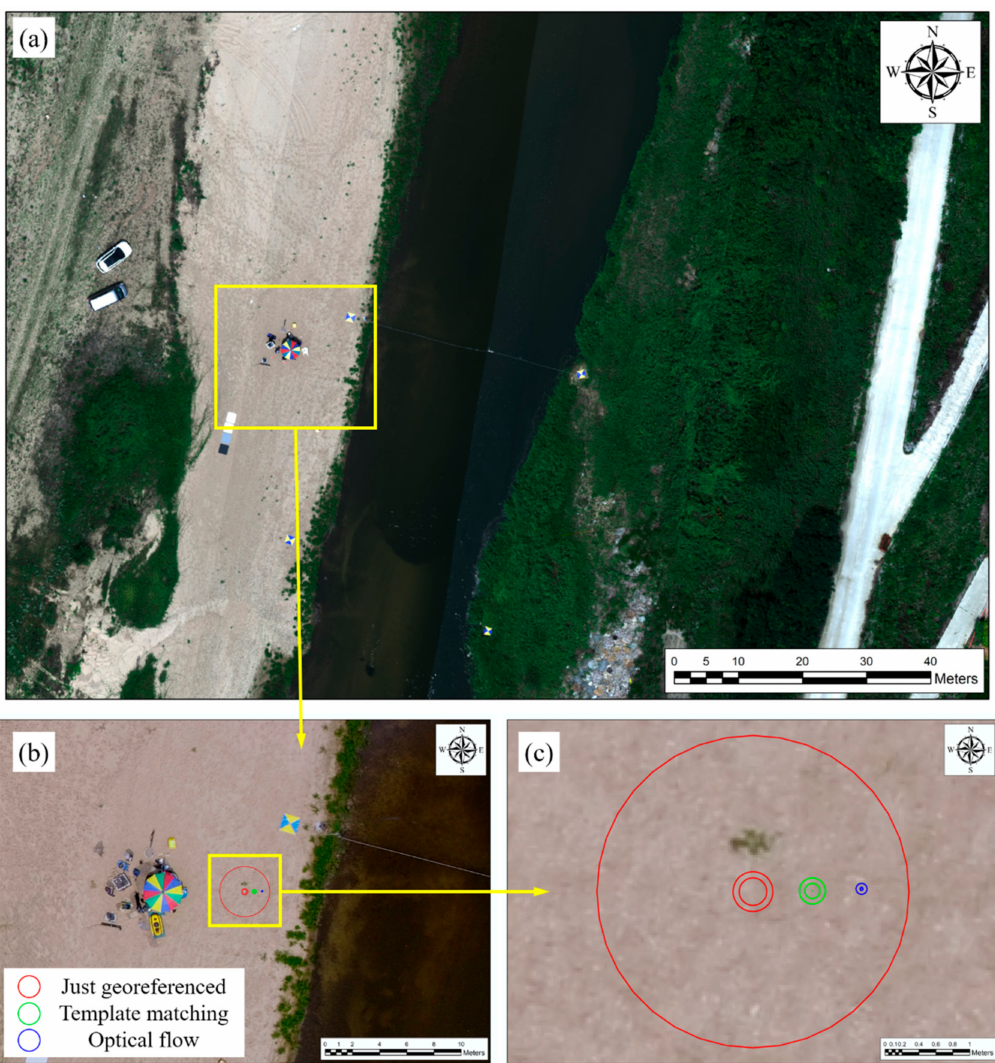
Figure 13. Comparison of spatial error size by each method: ( a ) hyperspectral image to which the technique proposed in this study was applied; ( b ) minimum, maximum, and RMSE results achieved by applying georeferencing, template matching, and optical flow; ( c ) minimum, maximum, and RMSE error comparisons for the (red) just-georeferenced, (green) template matching, and (blue) optical flow, using circle